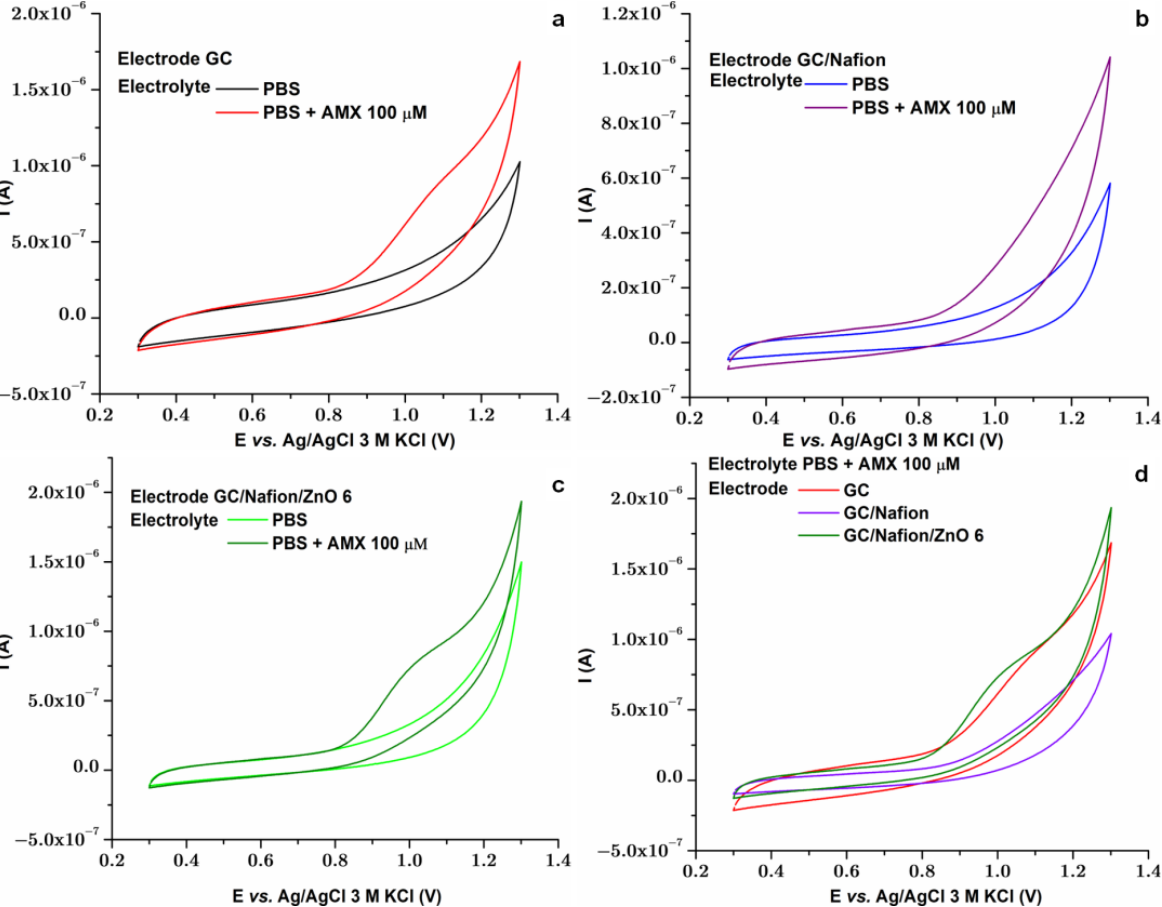
Figure 4. Cyclic voltammetry curves recorded in PBS and PBS + AMX 100 μM corresponding to ( a ) GC electrode, ( b ) GC/Nafion electrode, ( c ) GC/Nafion/ZnO 6, ( d ) GC/Nafion, and GC/Nafion/ZnO 6 compared with an uncoated GC electrode.